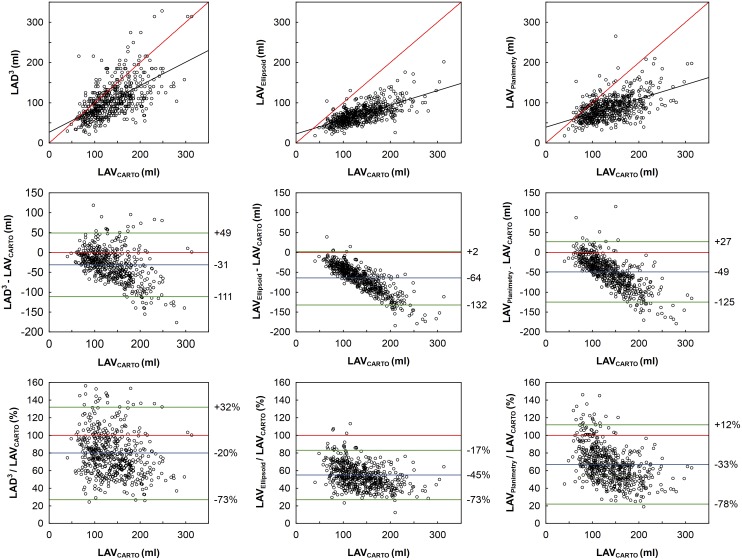
Correlation and agreement between 2D-ECHO-based and CARTO-derived LAV.Upper row: Pearson’s correlation. Middle row: scatterplots for absolute differences between 2D-ECHO-based and CARTO-derived LAV versus CARTO-derived LAV. Lower row: scatterplots for relative differences between 2D-ECHO-based and CARTO-derived LAV versus CARTO-derived LAV. Red line—identity line; black line—regression line; blue line—bias; green line—limits of agreement (±1.96 standard deviation). Abbreviations as in Fig 1.